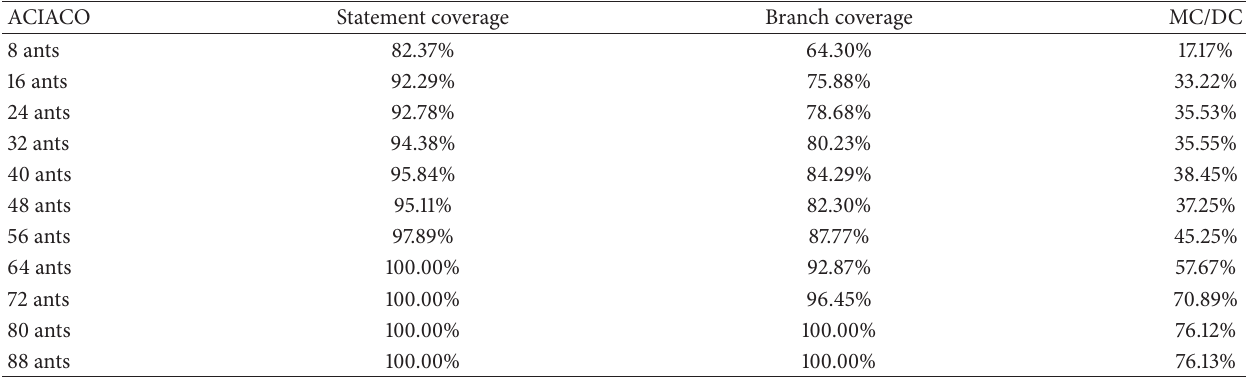
Table 6: The coverage of different ant numbers on ACIACO.